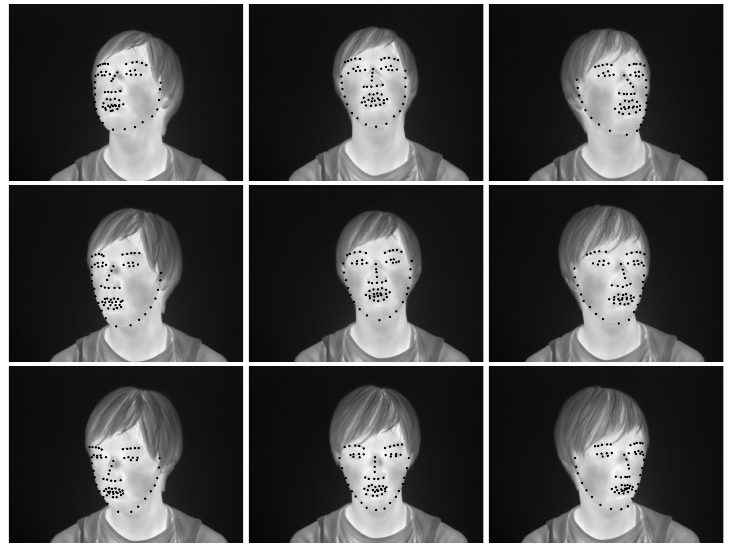
Figure 4. Examples of thermal infrared images oriented in nine different